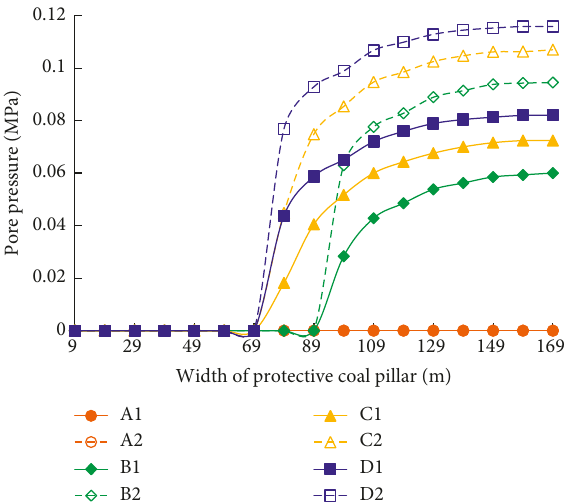
Figure 11: Pore pressure variation curves for the monitoring points with the width of the waterproof coal pillar.